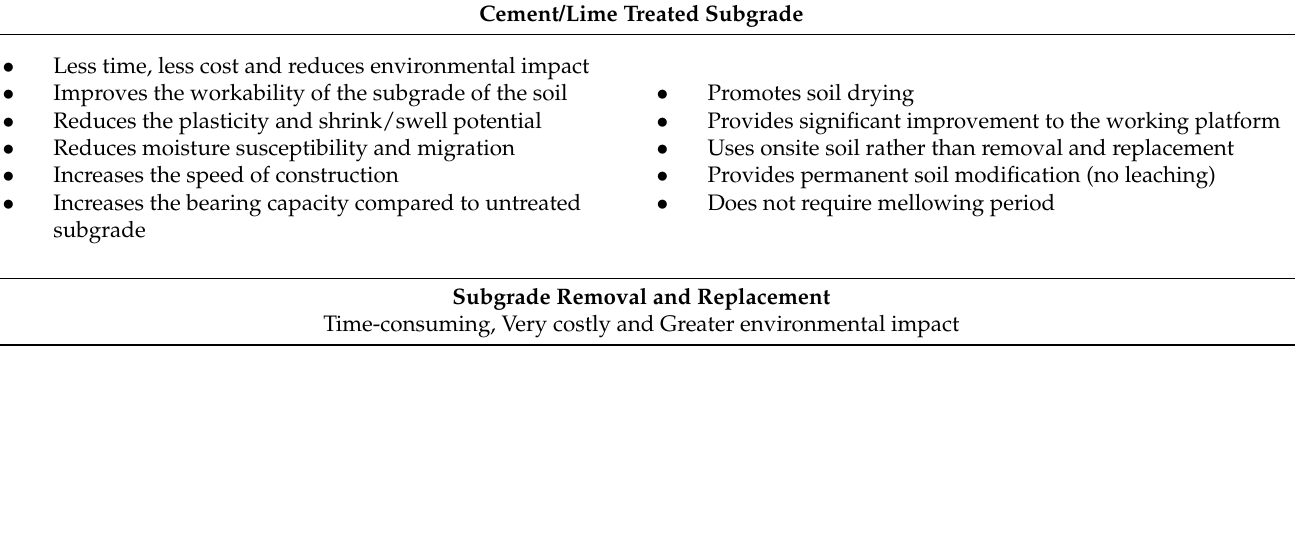
Table 1. The advantages of in situ treated subgrade and the disadvantages of the removal and replacement of